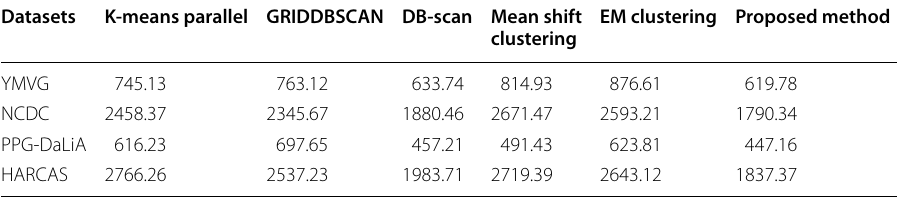
Table 4 Comparison of execution time (seconds)